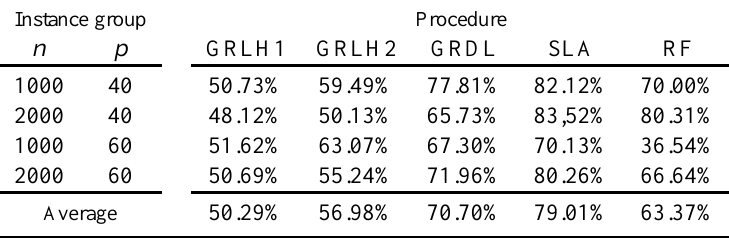
Table 9. Relative deviation for infeasibility results after im-